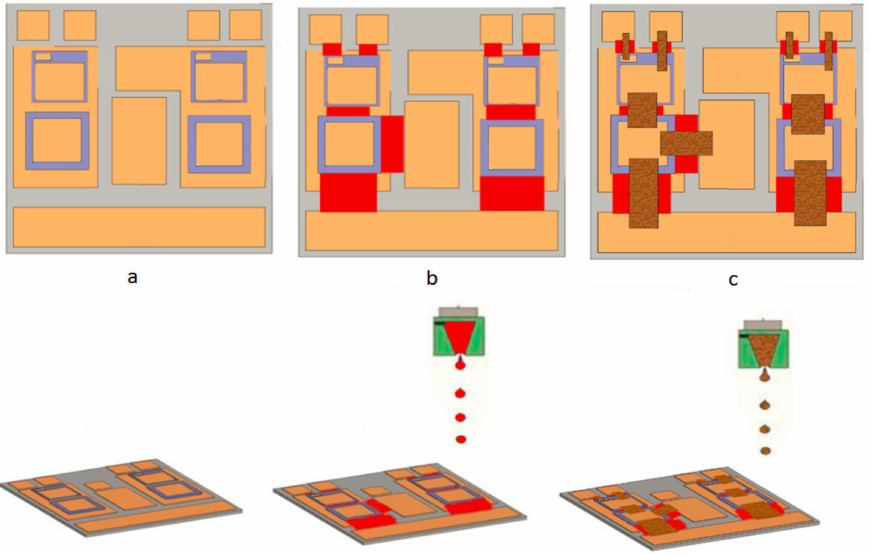
Figure 2. Illustration of the jet-printing process flow for producing top-side Cu sinterconnects ( a ) multi-chip direct-bond-copper (DBC) sub-assembly, ( b ) jet-printing of dielectric paste, ( c ) jet-printing of copper